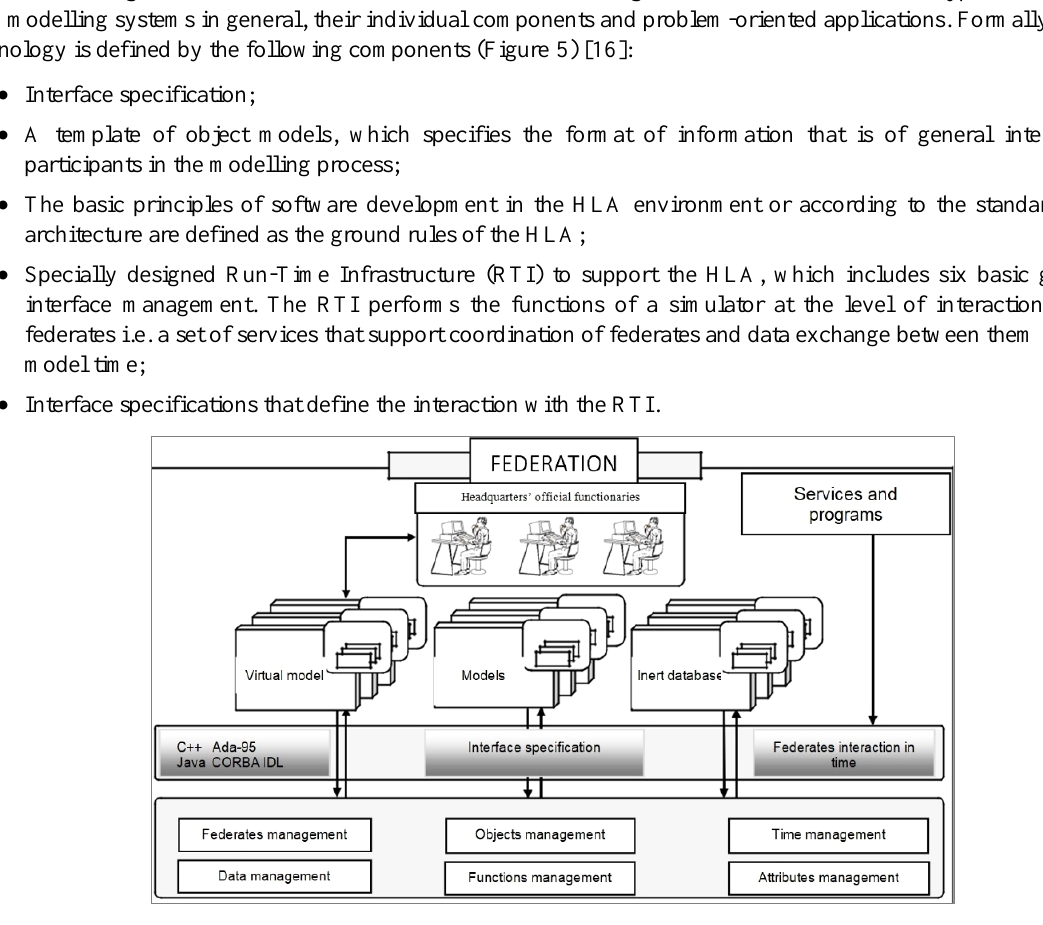
Figure 5. Virtual integrated HLA environment to support the processes of design and implementation of distributed